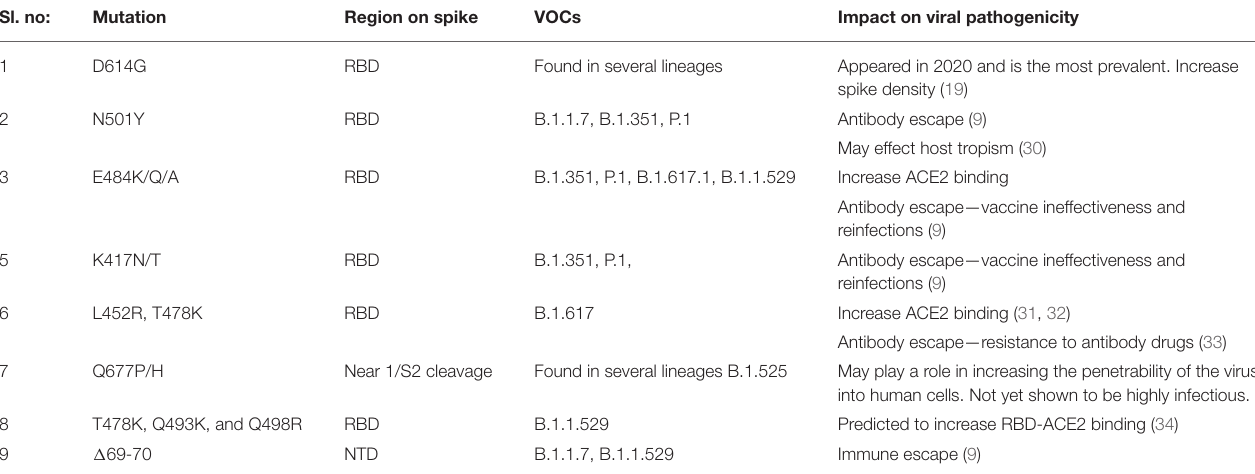
TABLE 2 | Mutations in the spike protein of SARS-CoV-2 variants that may be contributing to increased pathological properties. Sl.